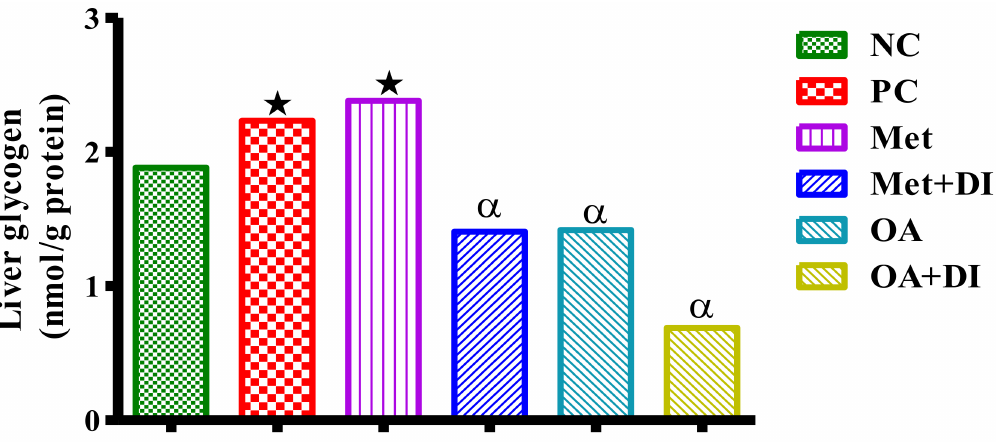
Figure 6. Effects of OA on liver glycogen concentrations of rats that continued with HFHC diet and those that changed diet or had diet intervention during treatment period. Values are presented as mean. (cid:70) = p < 0.05 denotes comparison with NC; α = p < 0.05 denotes comparison with